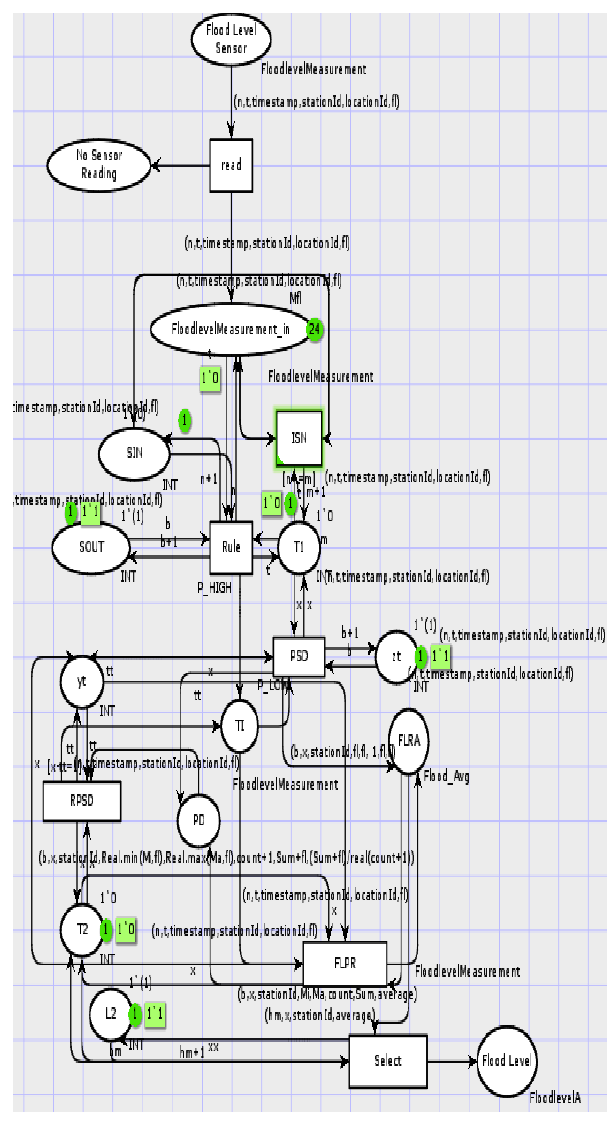
Figure 4 . IoT based flood water level sensor network CPN